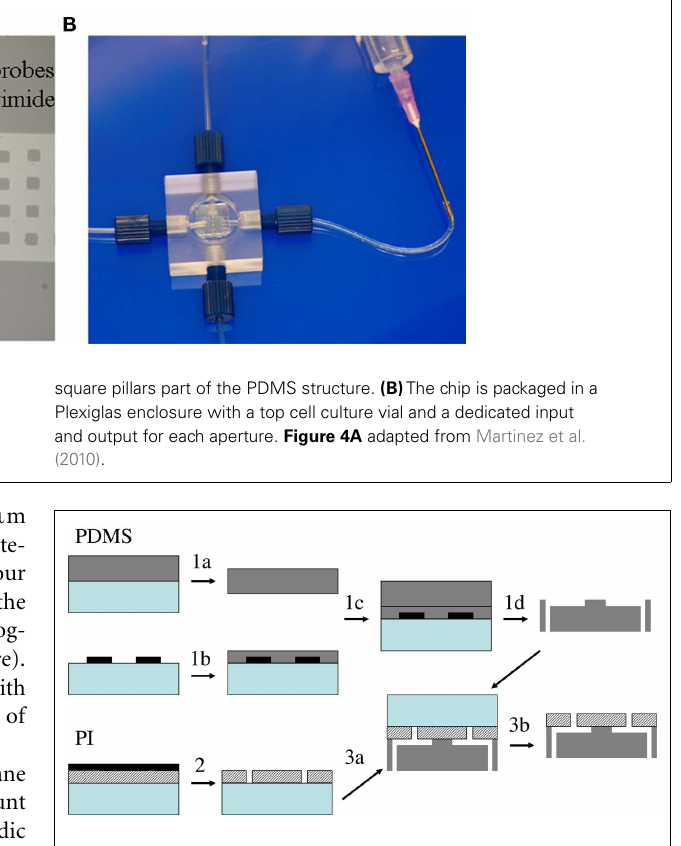
FIGURE 5 | PI–PDMS chip fabrication process. PDMS (dark gray, step 1) and PI (hatched, step 2) are processed independently on 2 (cid:2)(cid:2) Si wafers (light green); alignment-bonding (step 3a) and release (step 3b) form the final microchip. Adapted from Martinez et al.